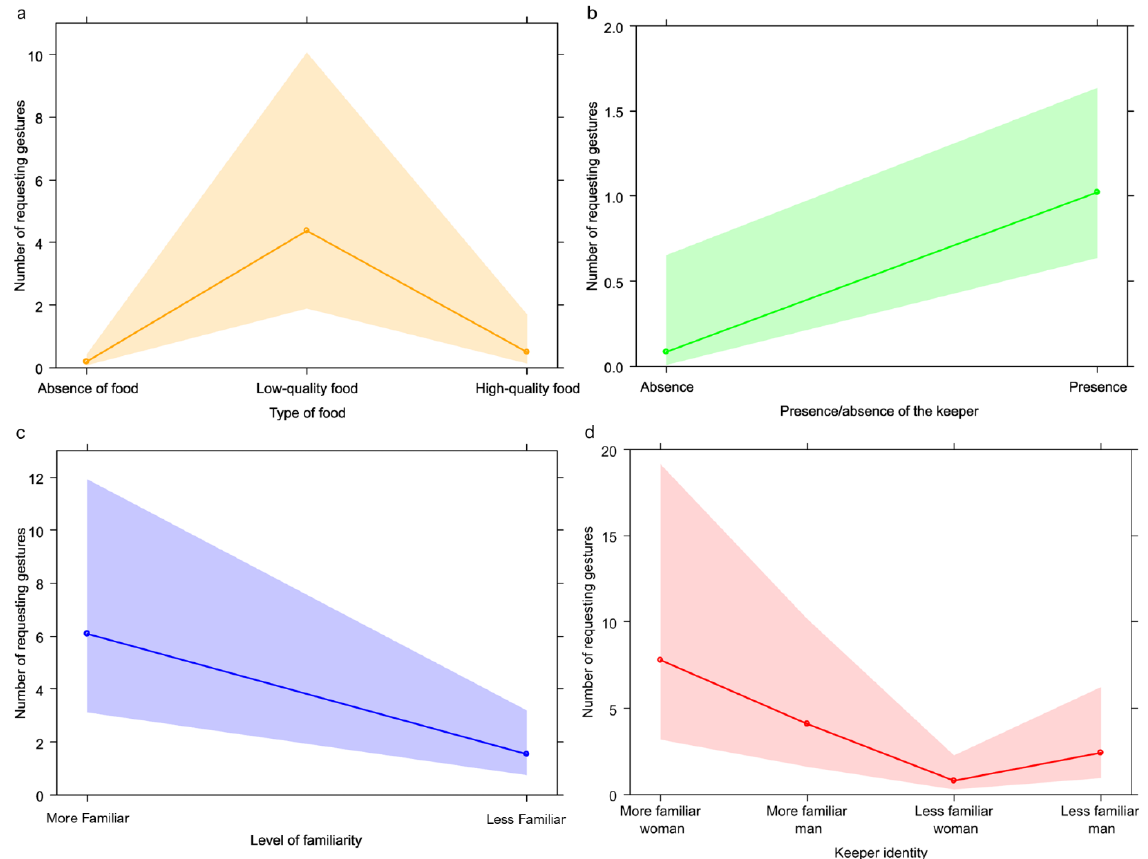
Figure 4. Effect plot of the variables with a significant effect on requesting gestures. The number of requesting gestures (y-axis) was ( a ) highest in presence of low-quality food (x-axis), ( b ) highest in presence of the keeper, ( c ) with more familiar keepers, and specifically ( d ) with the more familiar woman and man.